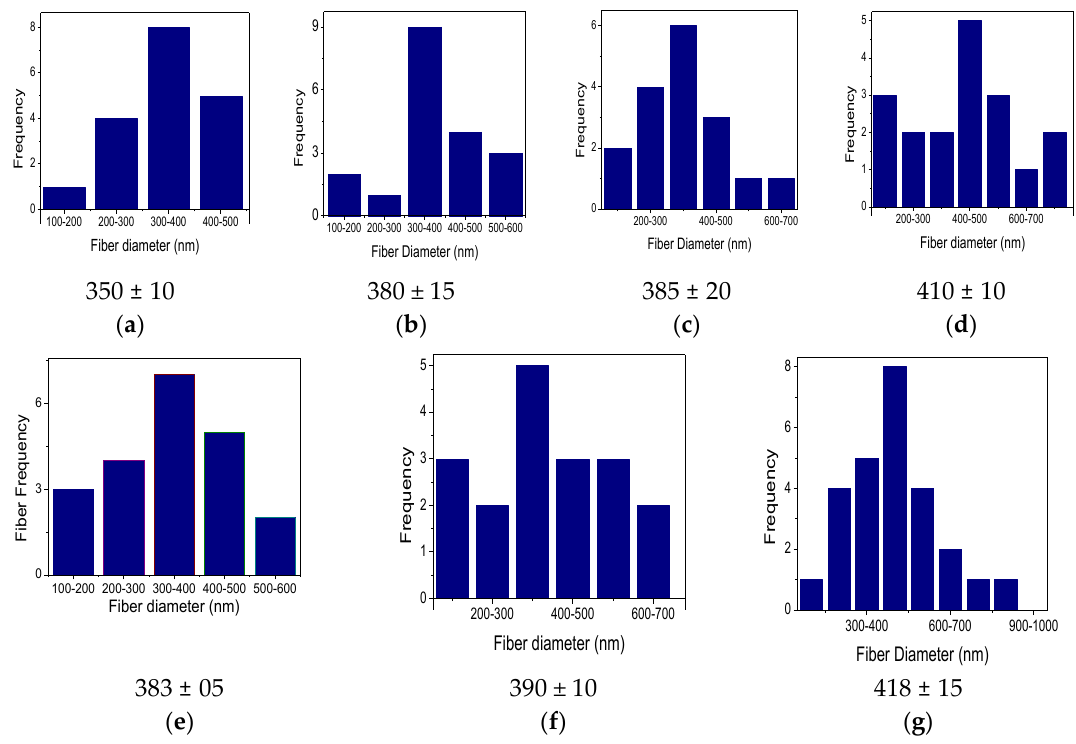
Figure 3. Average diameter distributions analysis of ( a ) Neat PVA nanofibers; ( b ) 5% PVA/ZnO nanofibers; ( c ) 7% PVA/ZnO nanofibers; ( d ) 9% PVA/ZnO nanofibers; ( e ) 5% PVA/TiO 2 nanofibers; ( f ) 7% PVA/TiO 2 nanofibers; ( g ) 9% PVA/TiO 2 nanofibers.